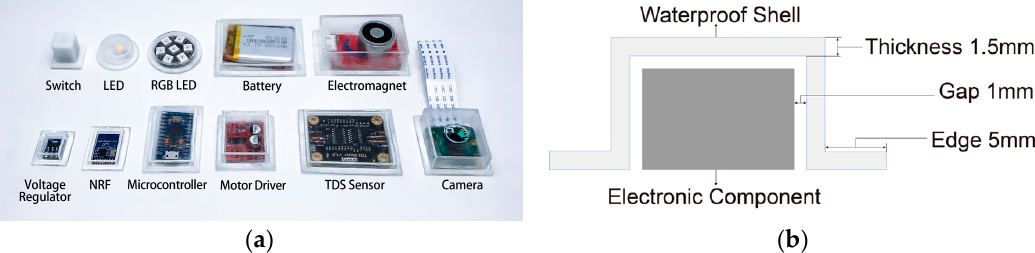
Figure 2. ( a ) Waterproof shells. The soft silicon shell of the switch is different from the others, and supports its ups and downs; and, ( b ) standard for making waterproof shells.